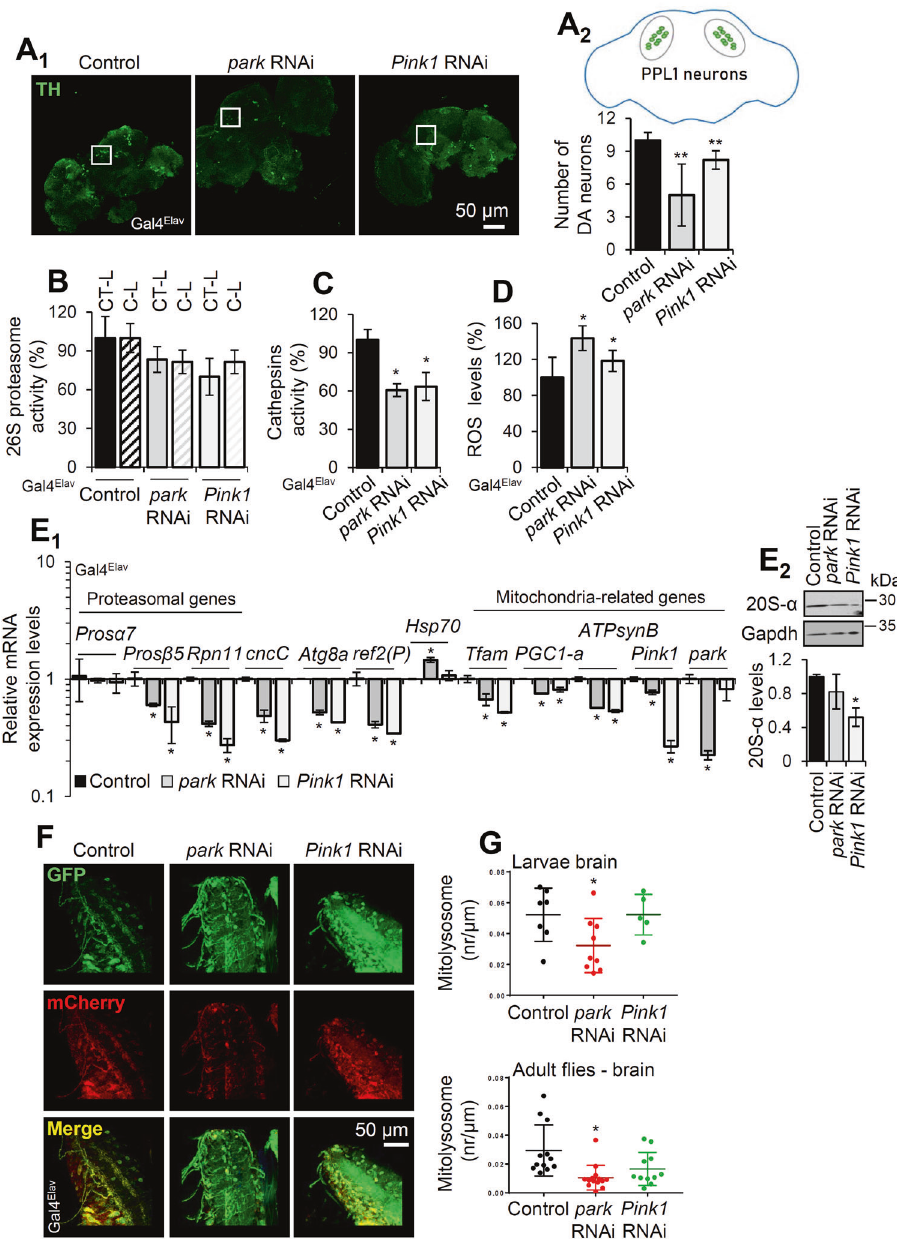
Fig. 3 Targeted KD of park or Pink1 in nervous tissues reduces brain DA neurons, downregulates proteostatic modules activities, induces oxidative stress and disrupts mitophagy. A CLSM viewing (projection, Z stack) of whole-mount brains from middle aged fl ies showing ( A 1 ) DA neuron clusters marked with anti-TH immunostaining, and ( A 2 ) quanti fi cation (vs. control) of DA PPL1 neurons in the brains of park or Pink1 KD transgenic fl ies. B – D Relative (%) chymotrypsin-like (CT-L) and caspase ‐ like (C ‐ L) like proteasome activities ( B ), cathepsins activities ( C ), and ROS levels ( D ), in fl ies ’ brain after KD of park or Pink1 genes. E 1 Relative mRNA expression of proteasomal subunits, cncC/ Nrf2 , autophagy-related ( Atg8a, ref( 2 )P/p62 ) , Hsp70 and mitochondria-related genes in transgenic fl ies of the indicated genotypes. E 2 Immunoblot analyses and relative quanti fi cation of the shown transgenic fl ies ’ brain samples probed with antibodies against 20S- α proteasomal subunits ( n = 2). F CLSM visualization of the Mito-QC reporter GFP and mCherry signal in larvae nervous tissues, and ( G ) quanti fi cation of mitolysosomes after park or Pink1 KD in larvae (upper panel) and adult fl ies (lower panel) brain. A – G Tgs were expressed in nervous tissues (Gal4 Elav ). Gene expression in ( E 1 ) was plotted vs. control set to 1; RpL32 / rp49 gene was used as reference. Gapdh probing in ( E 2 ) was used to demonstrate equal protein loading. Bars, ±SD; n = 3, * P < 0.05; ** P <